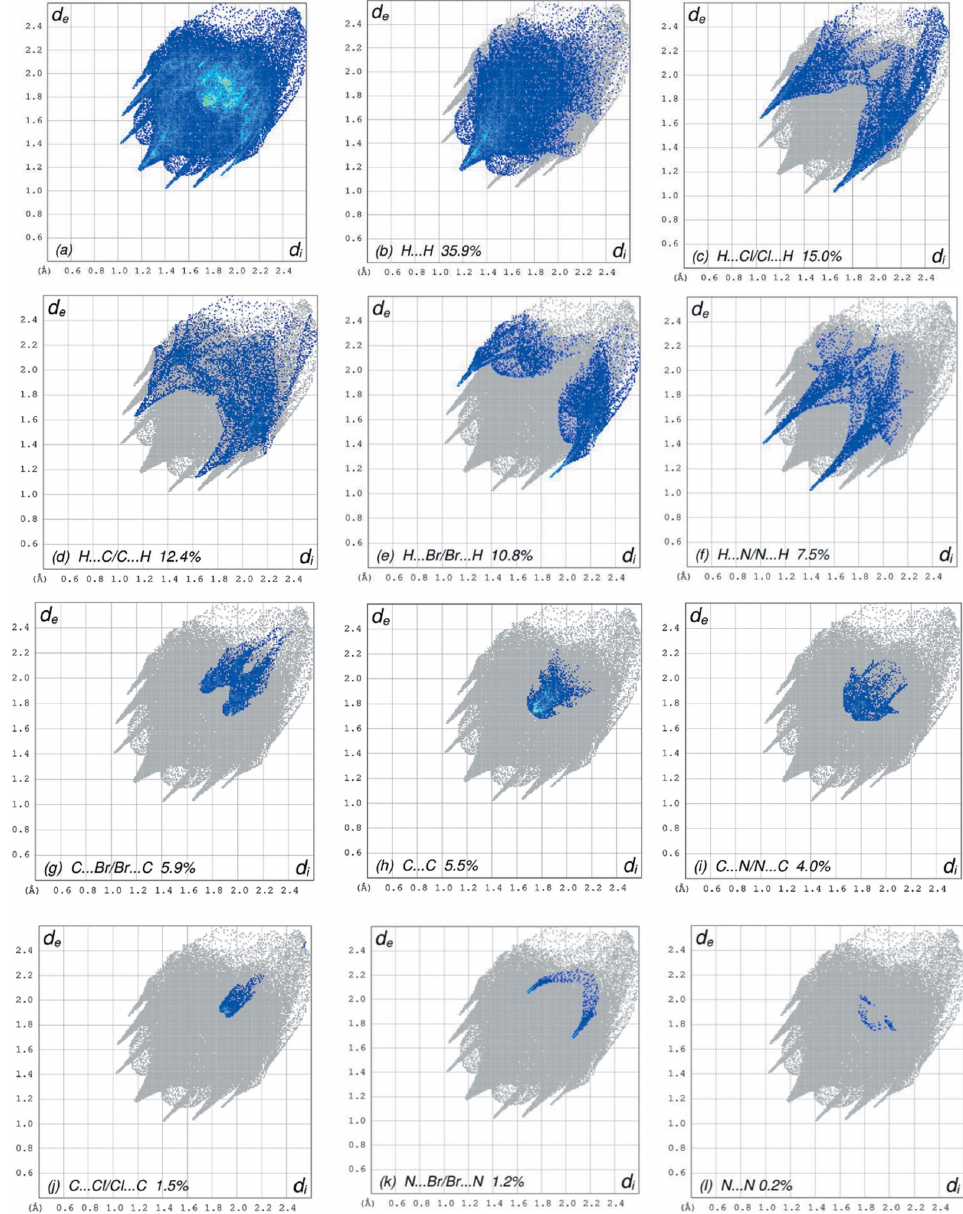
Figure 5 The full two-dimensional fingerprint plots for the title compound, showing ( a ) all contacts, and delineated into ( b ) H (cid:3)(cid:3)(cid:3) H, ( c ) H (cid:3)(cid:3)(cid:3) Cl/Cl (cid:3)(cid:3)(cid:3) H, ( d ) H (cid:3)(cid:3)(cid:3) C/ C (cid:3)(cid:3)(cid:3) H, ( e ) H (cid:3)(cid:3)(cid:3) Br/Br (cid:3)(cid:3)(cid:3) H, ( f ) H (cid:3)(cid:3)(cid:3) N/N (cid:3)(cid:3)(cid:3) H, ( g ) C (cid:3)(cid:3)(cid:3) Br/Br (cid:3)(cid:3)(cid:3) C, ( h ) C (cid:3)(cid:3)(cid:3) C, ( i ) C (cid:3)(cid:3)(cid:3) N/N (cid:3)(cid:3)(cid:3) C, ( j ) C (cid:3)(cid:3)(cid:3) Cl/Cl (cid:3)(cid:3)(cid:3) C, ( k ) N (cid:3)(cid:3)(cid:3) Br/Br (cid:3)(cid:3)(cid:3) N and ( l ) N (cid:3)(cid:3)(cid:3) N contacts. The d i and d e values are the closest internal and external distances (in A˚ ) from given points on the Hirshfeld surface